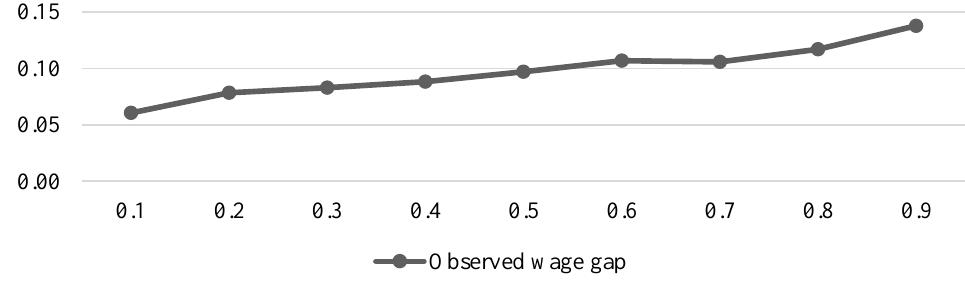
Fig. 3. Decomposition of the ethnic wage gap by deciles (log-points; 2015). *Difference in % can be calculated as exp (difference in log points)-1 Source: authors’ calculations using LFS micro data